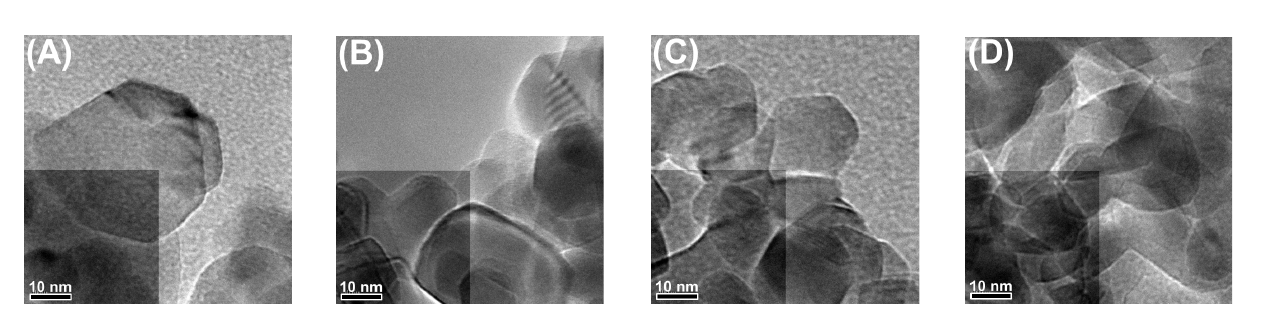
/TiO samples with varying Mn-loading amount ( Γ /ions nm − 2 ): x 2